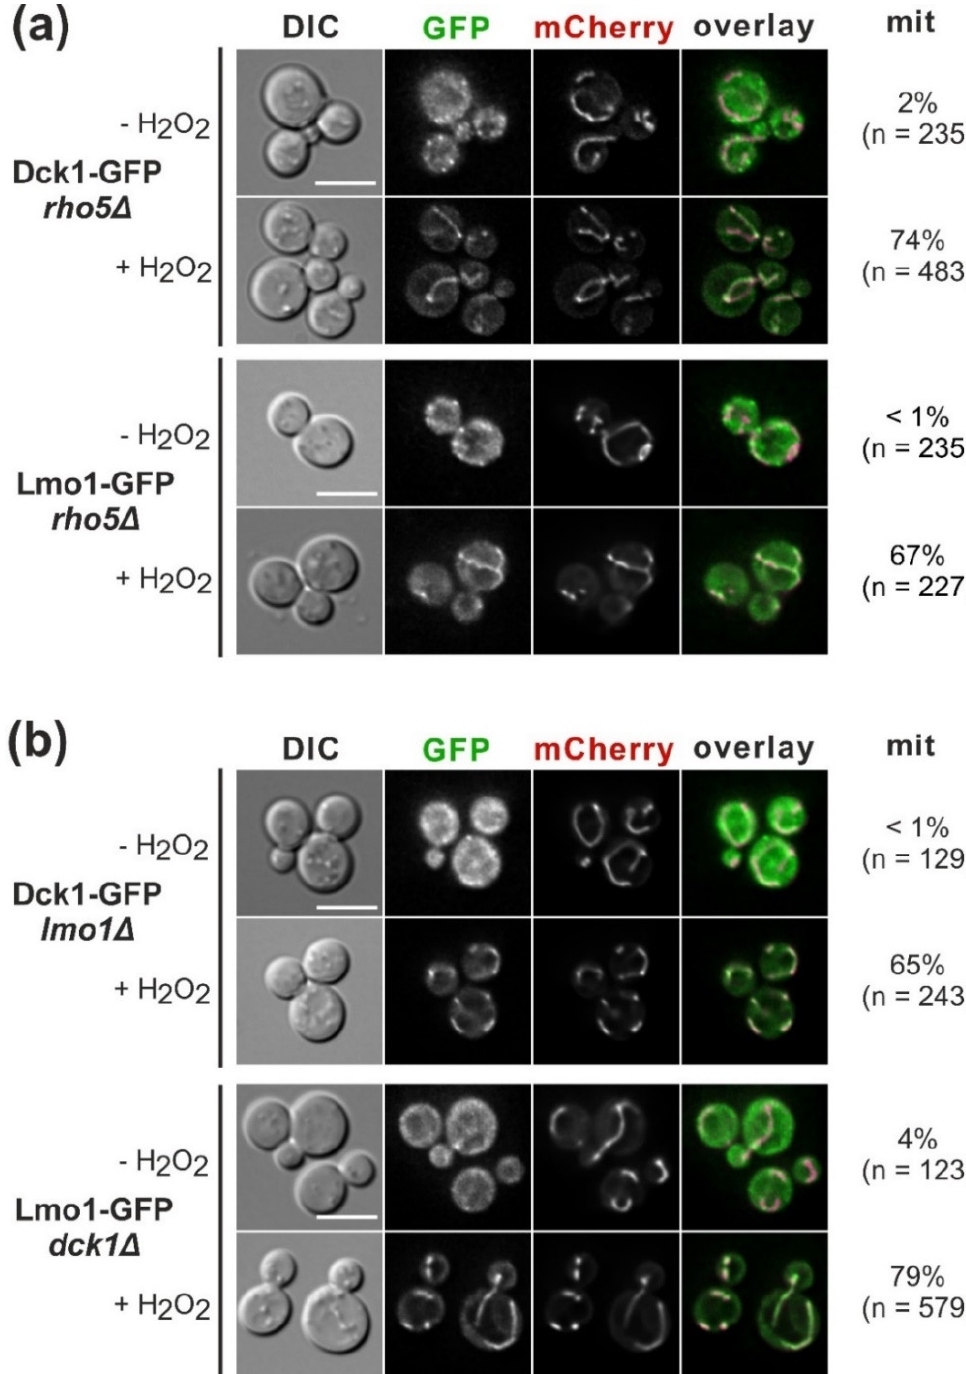
Figure 2. Requirements for translocation of Dck1 and Lmo1 to mitochondria under oxidative stress. ( a ) Dck1 and Lmo1 translocate independently from the presence of Rho5. ( b ) Dck1 and Lmo1 also translocate independent from each other. Strains expressing the GFP fusions of the indicated pro- teins from their native genomic loci were used to introduce a mitochondrial marker tagged with mCherry on a CEN/ARS plasmid (pJJH1408). Transformants were grown in selective minimal me- dia. Representative images for each strain and condition are shown. When oxidative stress was ap- plied by the addition of 4.4 mM hydrogen peroxide (+H 2 O 2 ), fluorescence images were taken within